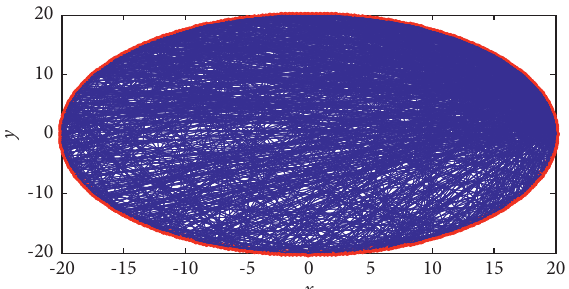
Figure 2: Graph of scale-free network (when n � 400, d � 6).